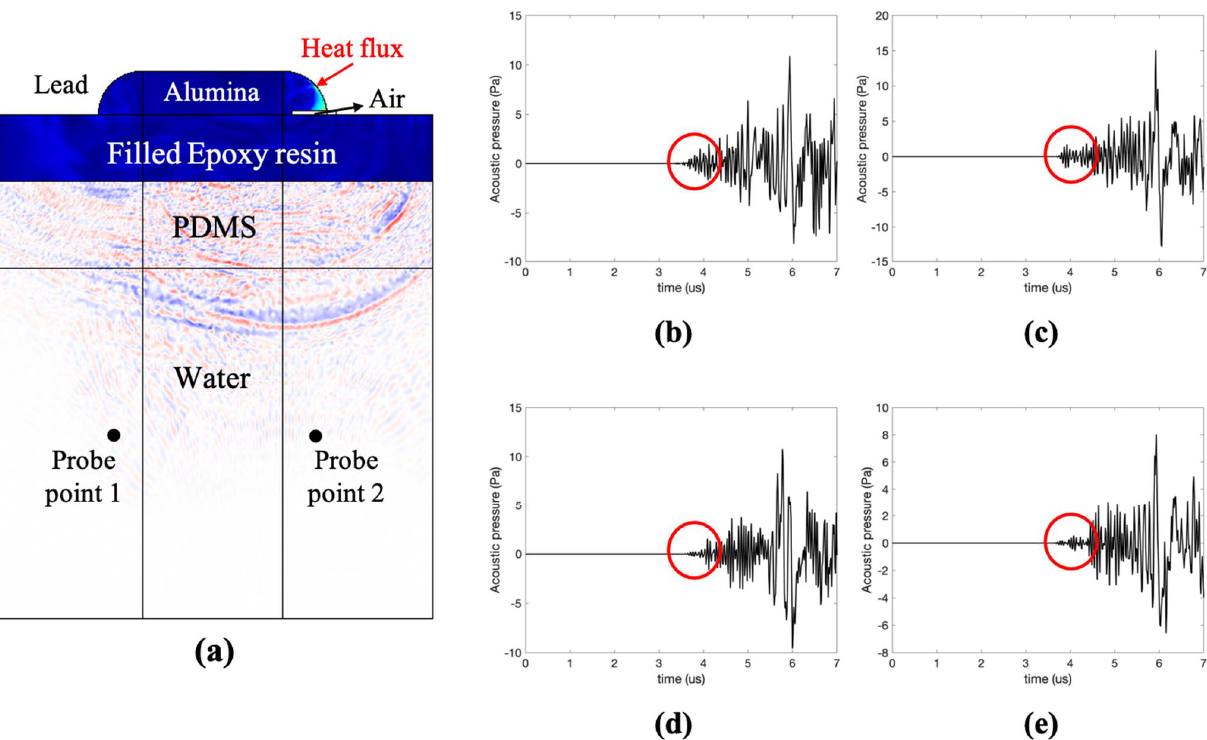
Figure 2. ( a ) The geometry of the simulation model, and wave propagation of the generated acoustic signal at cracked part, A-scan data of ( b ) normal part, ( c ) 0.1 mm-wide crack, ( d ) 0.5 mm-wide crack, and ( e ) 1 mm-wide crack. Table 1. Material properties of heat transfer model components.